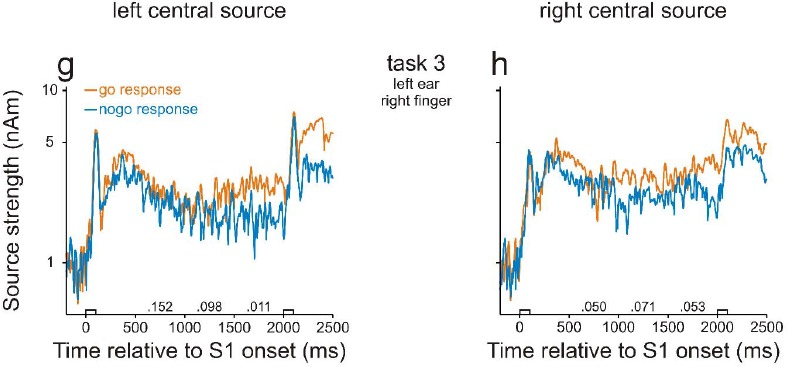
DOI:
http://dx.doi.org/10.7554/eLife.15441.015